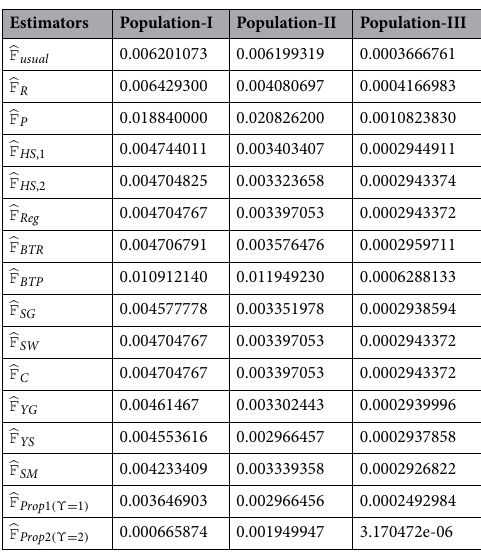
Table 4. MSE using simulated data sets.